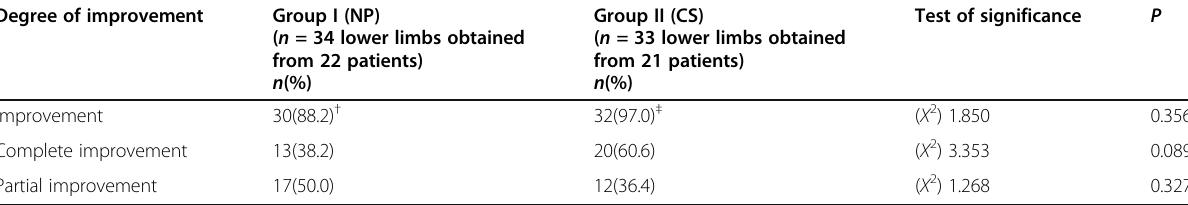
Table 4 Comparison between the two treatment groups regarding the degree of improvement of chronic anserine bursitis at